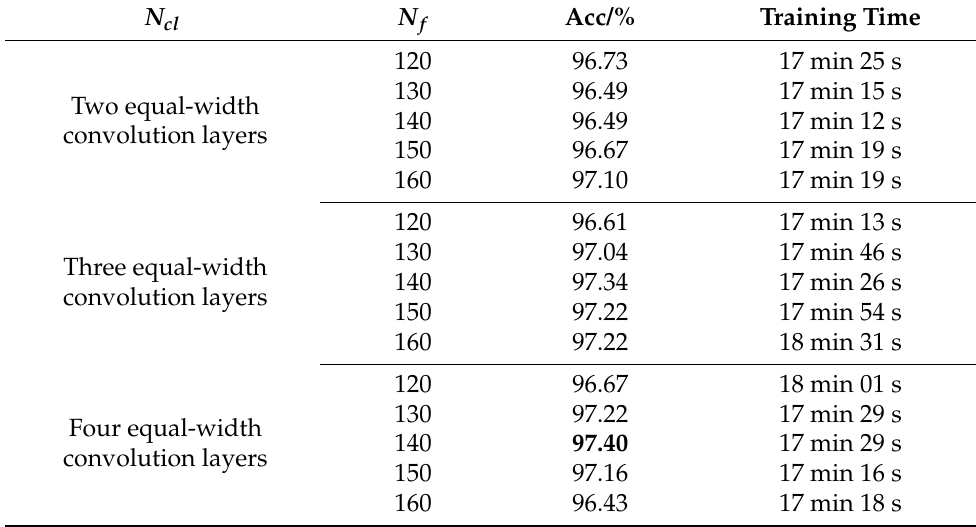
Table 3. Accuracy and training time under different N cl and N f .